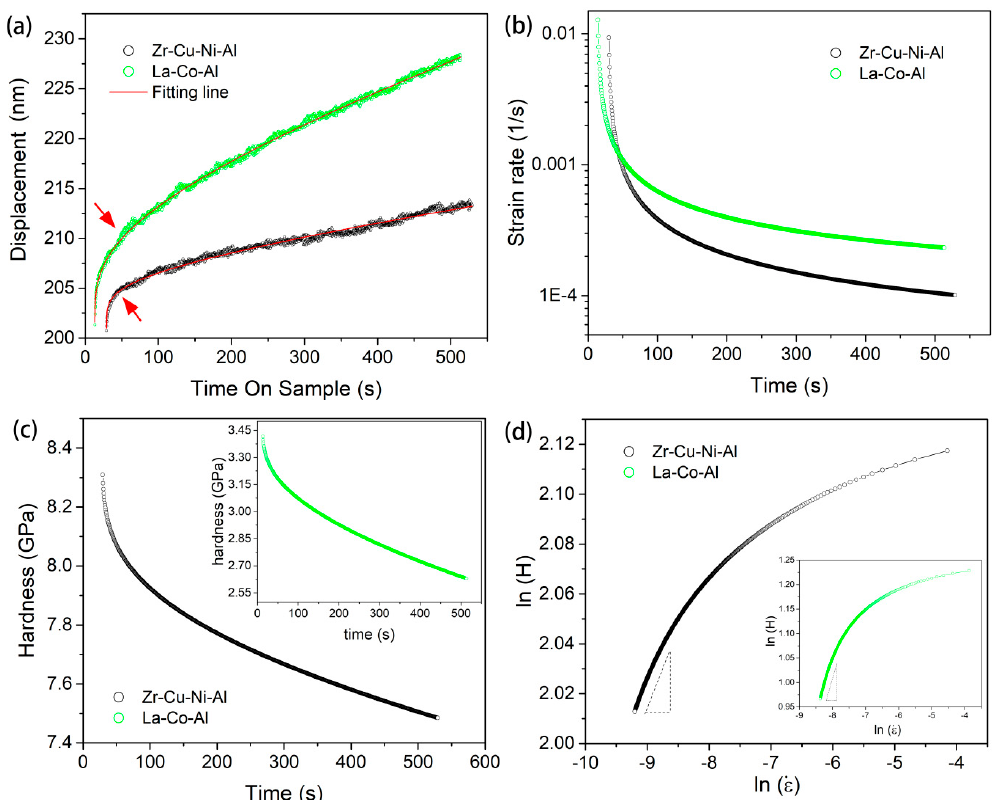
Figure 3. ( a ) the creep displacements during the holding stage versus holding time, which can be perfectly fitted using an empirical law, and the critical point of creep transition from transient stage to steady-state stage is marked with an arrow; ( b ) the creep strain rate versus holding time; ( c ) the hardness versus holding time; ( d ) the log-log correlation between the hardness and strain rate obtained from the creep, strain rate sensitivity can be thus estimated by linear fitting of the steady-state part.